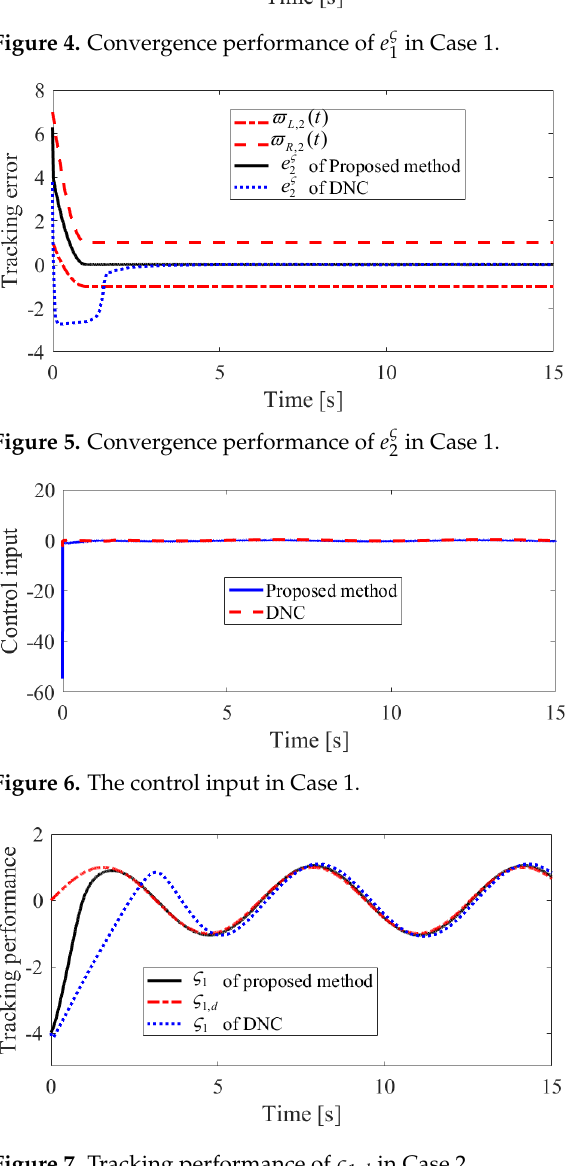
Figure 7. Tracking performance of ς 1, d in Case